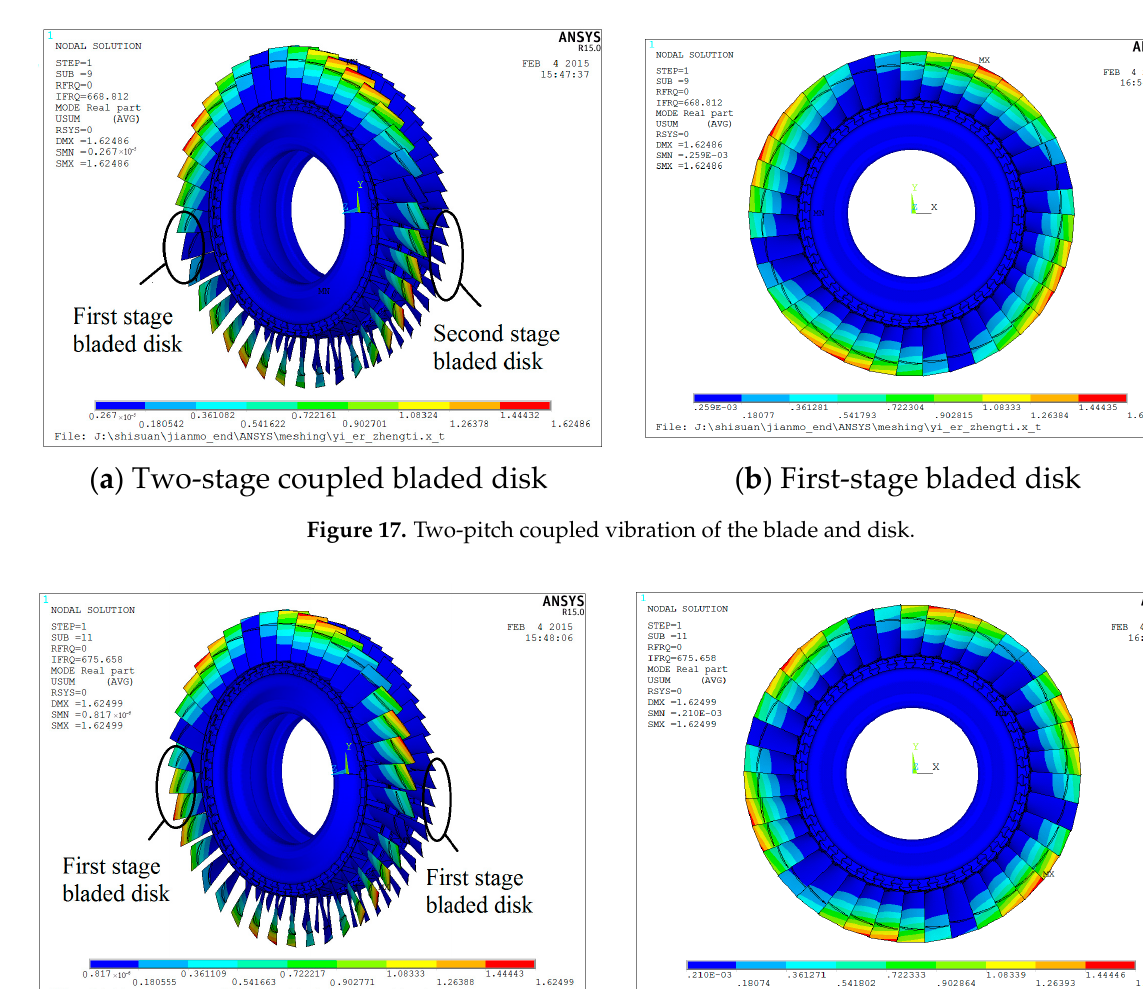
Figure 16. One-pitch coupled vibration of the blade and disk.